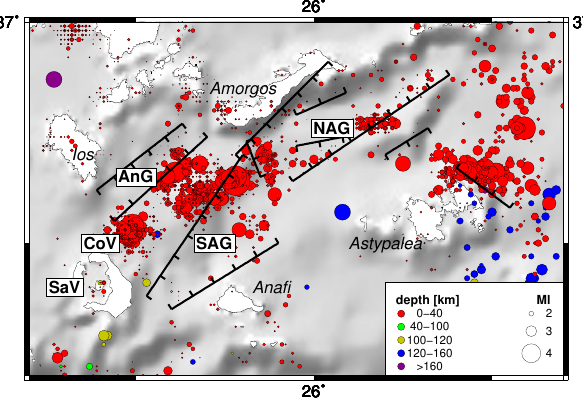
Figure 1. Well-located microseismic events observed during the CYCNET (CYClades NETwork) and EGELADOS (Exploring the GEodynamics of subducted Lithosphere using an Amphibian De- ployment Of Seismographs) experiments in the Santorini–Amorgos region (Brüstle, 2012). Included are locations of major fault struc- tures in the area according to Perissoratis and Papadopoulos (1999) and Stiros et al. (1994). SAG: southern Amorgos graben; NAG: northern Amorgos graben; CoV: Coloumbo volcano; SaV: Santorini Volcano; AnG: Anidros